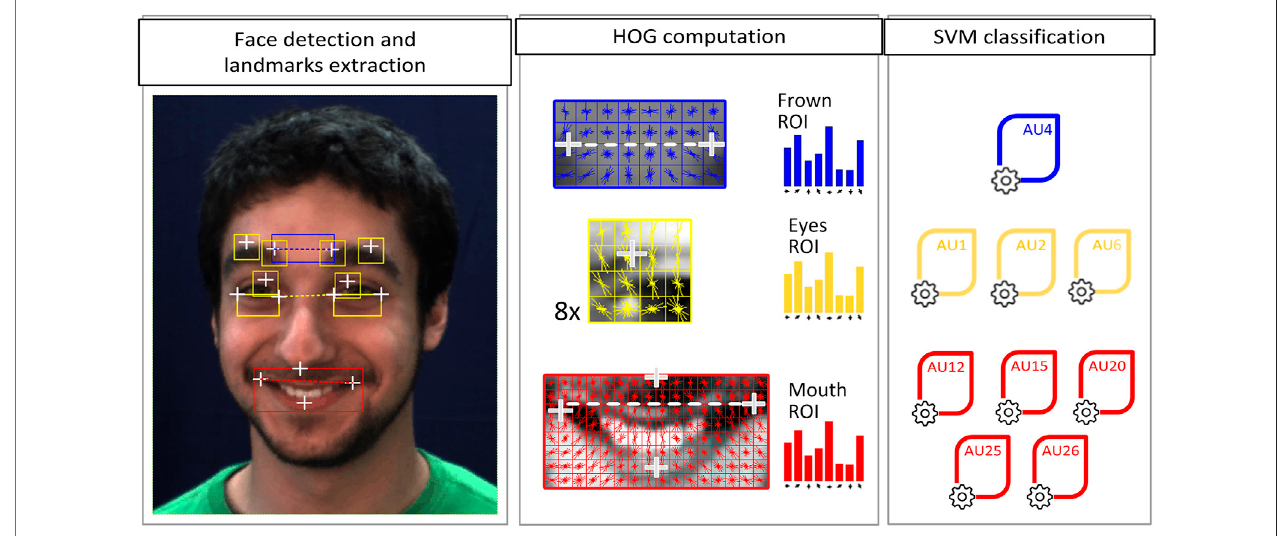
FIGURE 6 | AU intensity detection pipeline. The white crosses represent the facial landmarks extracted from the face, while the dashed lines link the landmarks used for aligning each ROI.